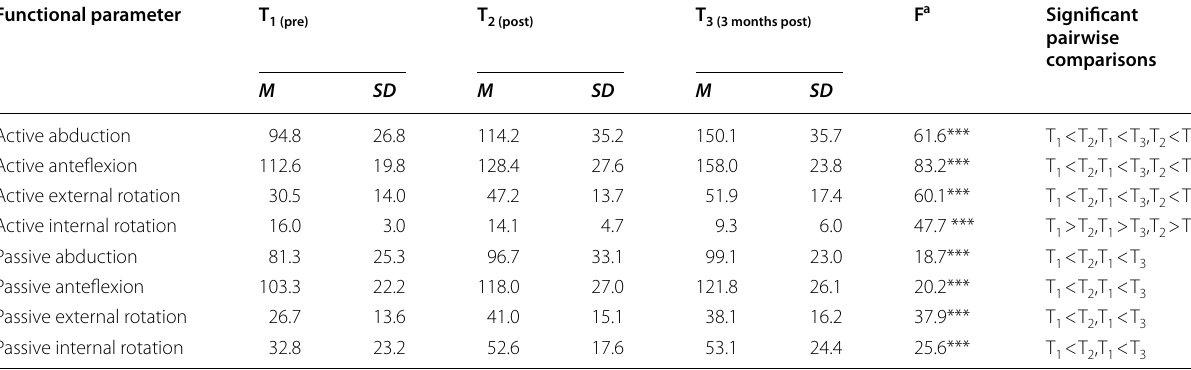
Note: T1 before HD, T2 immediately after HD, T3 3 months after HD, M Mean, SD Standard Deviation a F-test based on the independent pairwise comparisons among the estimated marginal means *** p <